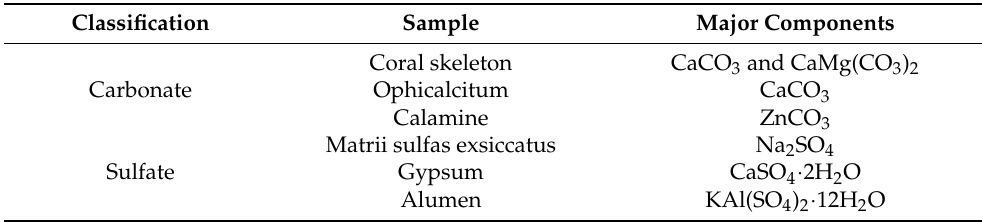
Figure 1. Pictures of ( a ) coral skeleton, ( b ) ophicalcitum, ( c ) calamine, ( d ) matrii sulfas exsiccatus, ( e ) gypsum, and ( f ) alumen. Table 1. Classification and main components of mineral